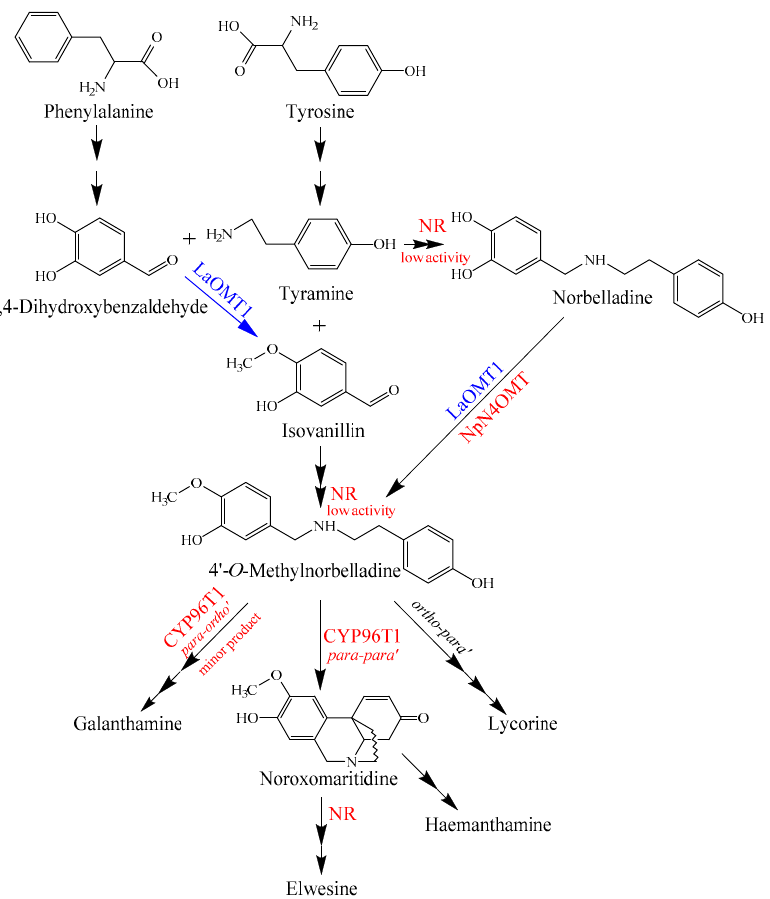
Figure 7. Proposed Amaryllidaceae alkaloids biosynthesis pathway in L. aurea . LaOMT1 involved in the pathway is indicated in blue. NpN4OMT and the possible homologues of Narcissus sp. aff. Pseudonarcissus noroxomaritidine reductase (NR) and C-C phenol coupling cytochrome P450 (CYP96T1) were indicated in red.